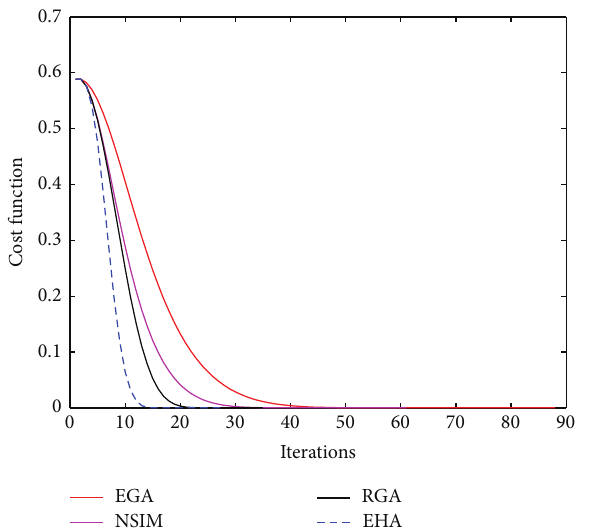
Figure 2: Kinetic energy in the EHA.